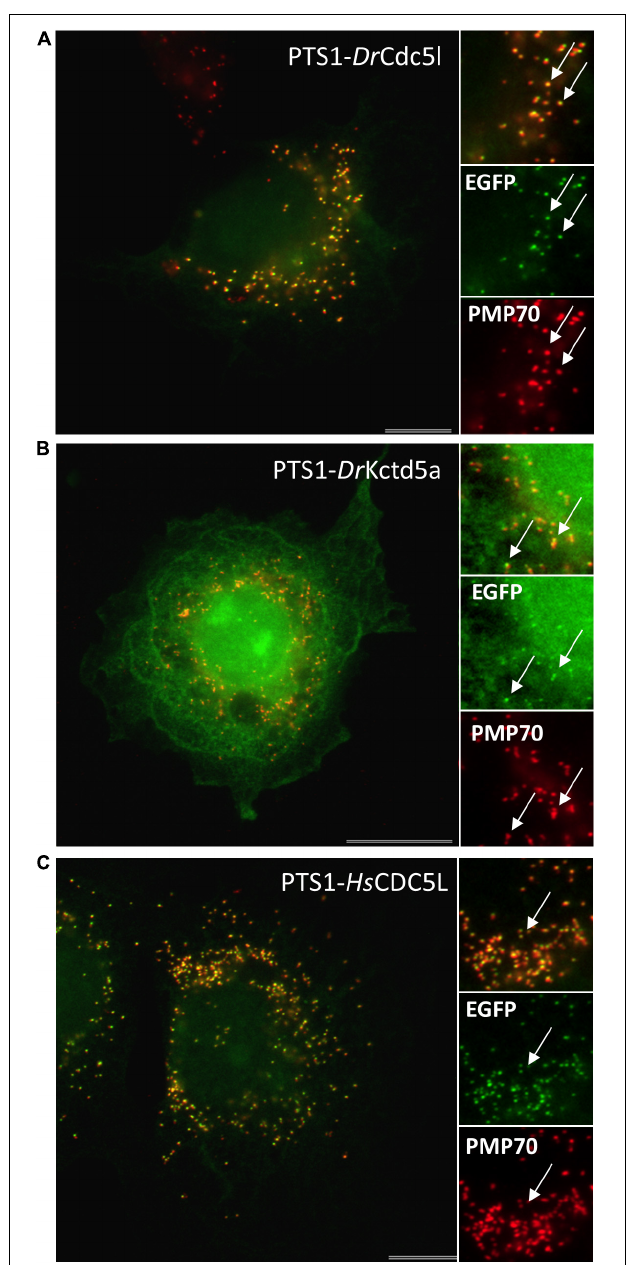
FIGURE 5 | Verification of PTS1 functionality for selected candidate proteins. COS-7 cells were transfected with an EGFP fusion protein containing the C-terminal putative PTS1 of D. rerio Cdc5l DLLMLDKQTLSSKI (A) , D. rerio Kctd5a DLKAKILQEQGSRM (B) , and H. sapiens CDC5L DLLLEKETLKSKF (C) . Cells were processed for immunofluorescence microscopy using anti-PMP70 (red) as a peroxisomal marker. White arrows